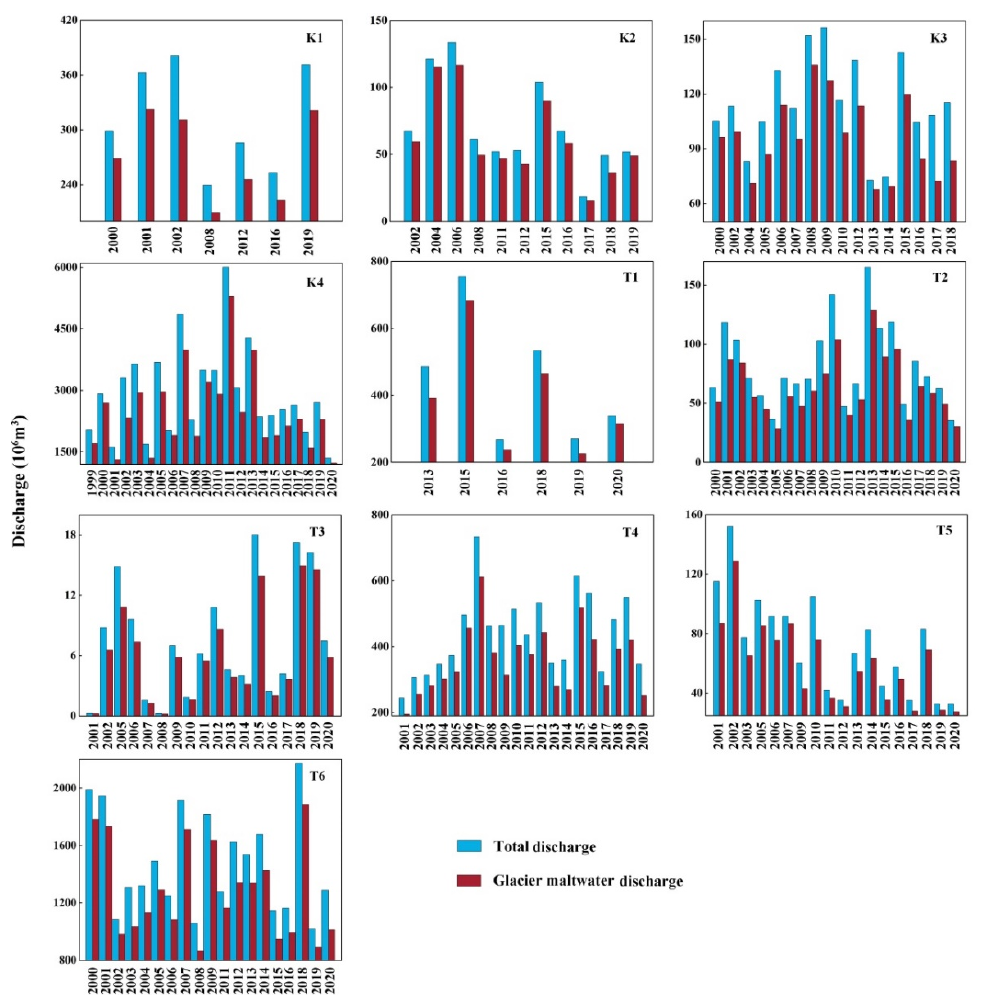
Figure 8. Annual total discharge and glacier meltwater discharge of studied sections during 1999–2020.